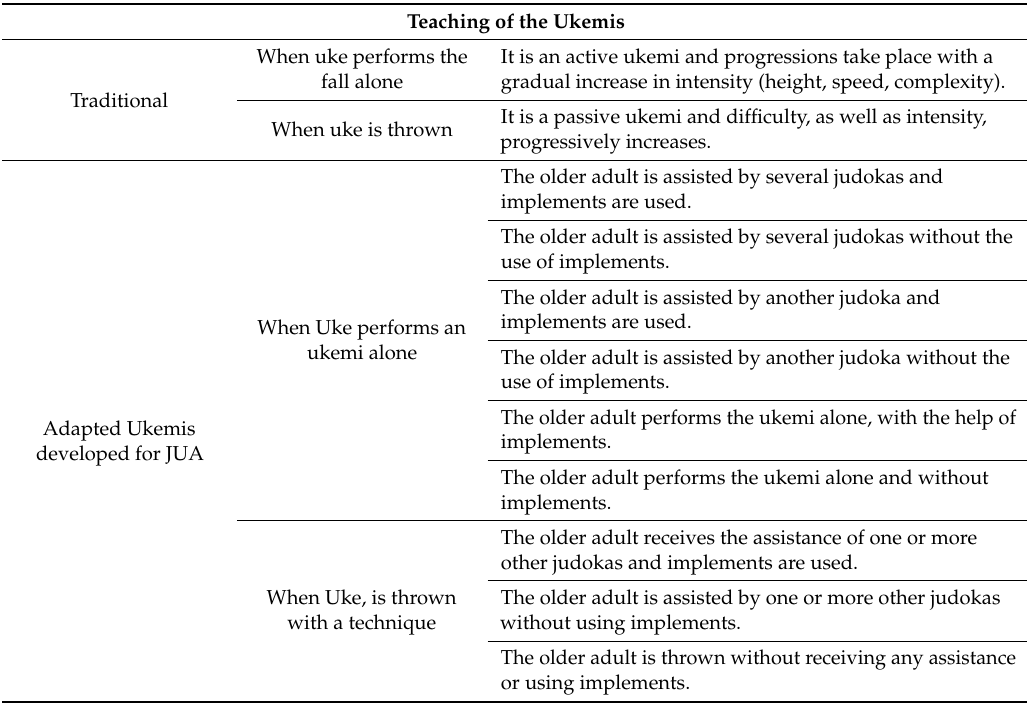
Table 1. Considerations on the work of assistance or help with falls, to provide its technical education to older